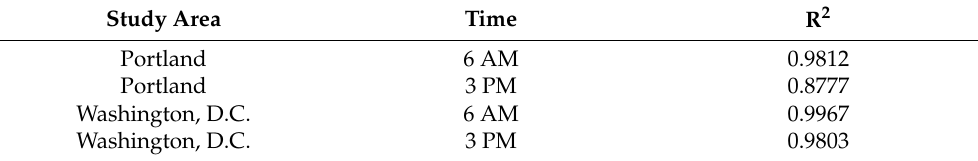
Table 1. Model Results.